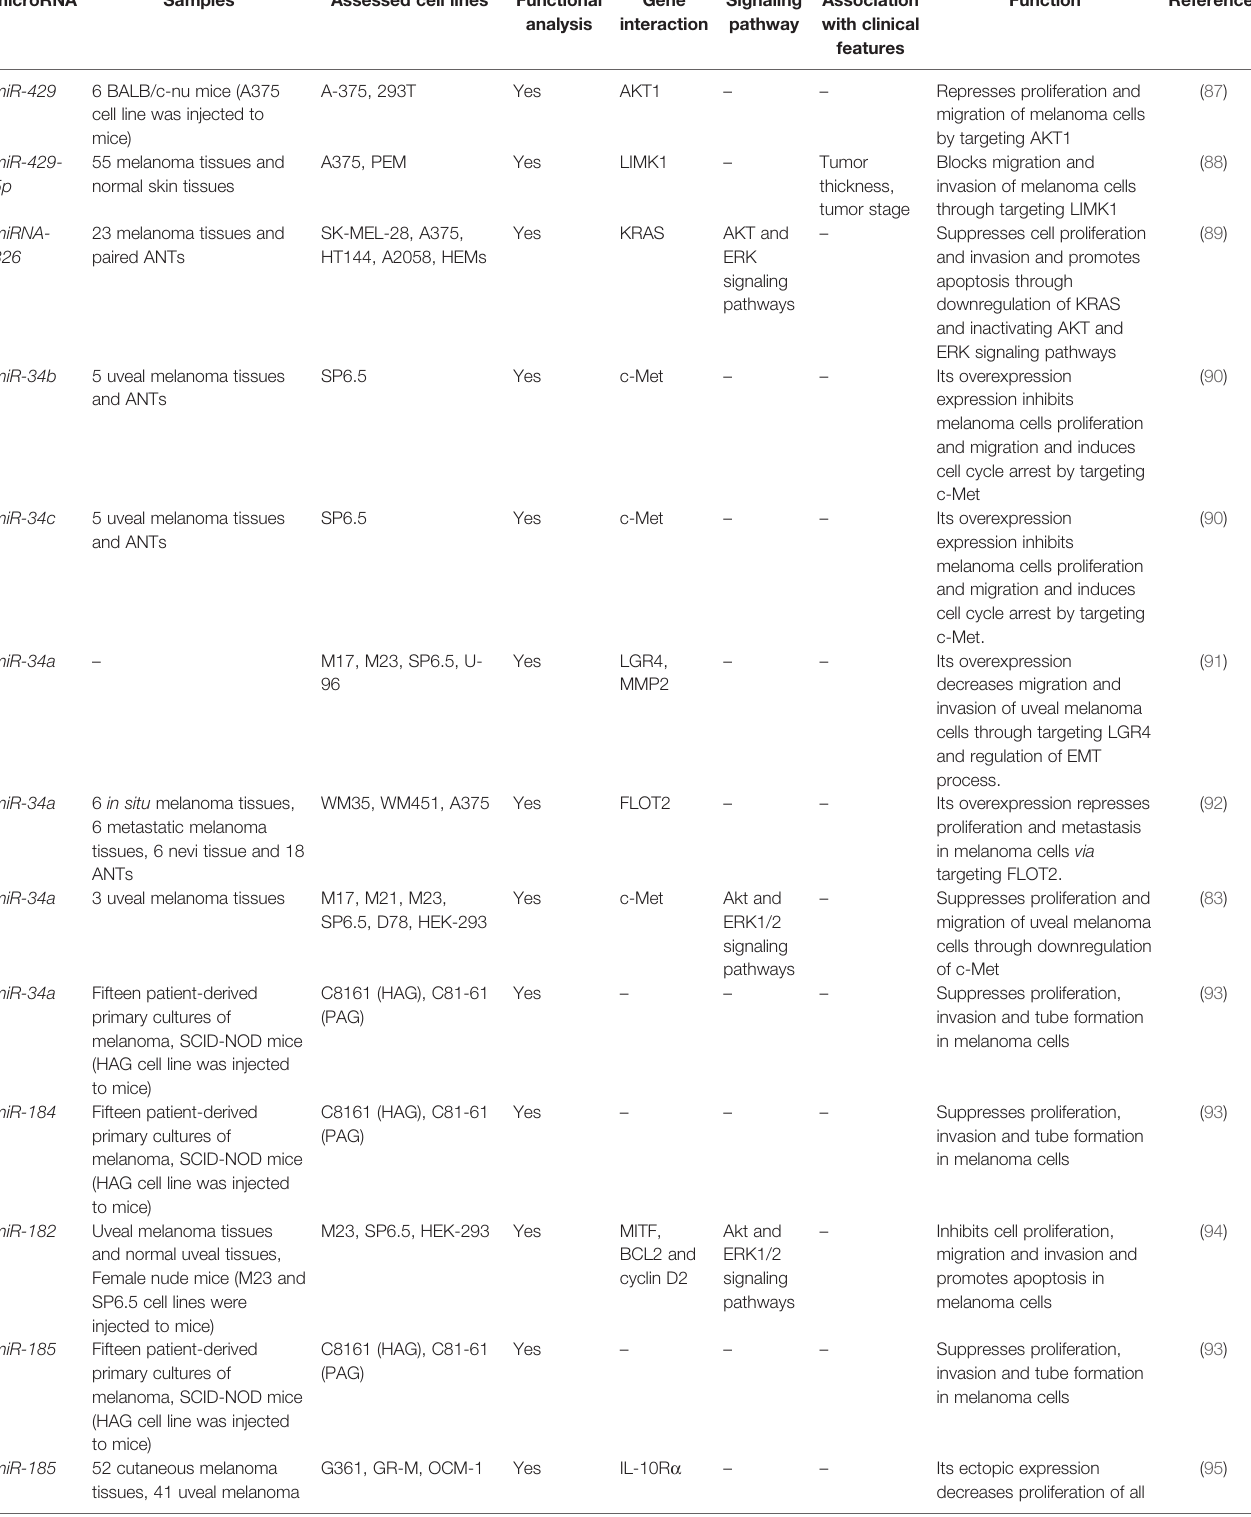
TABLE 2 | List of under-expressed miRNAs in